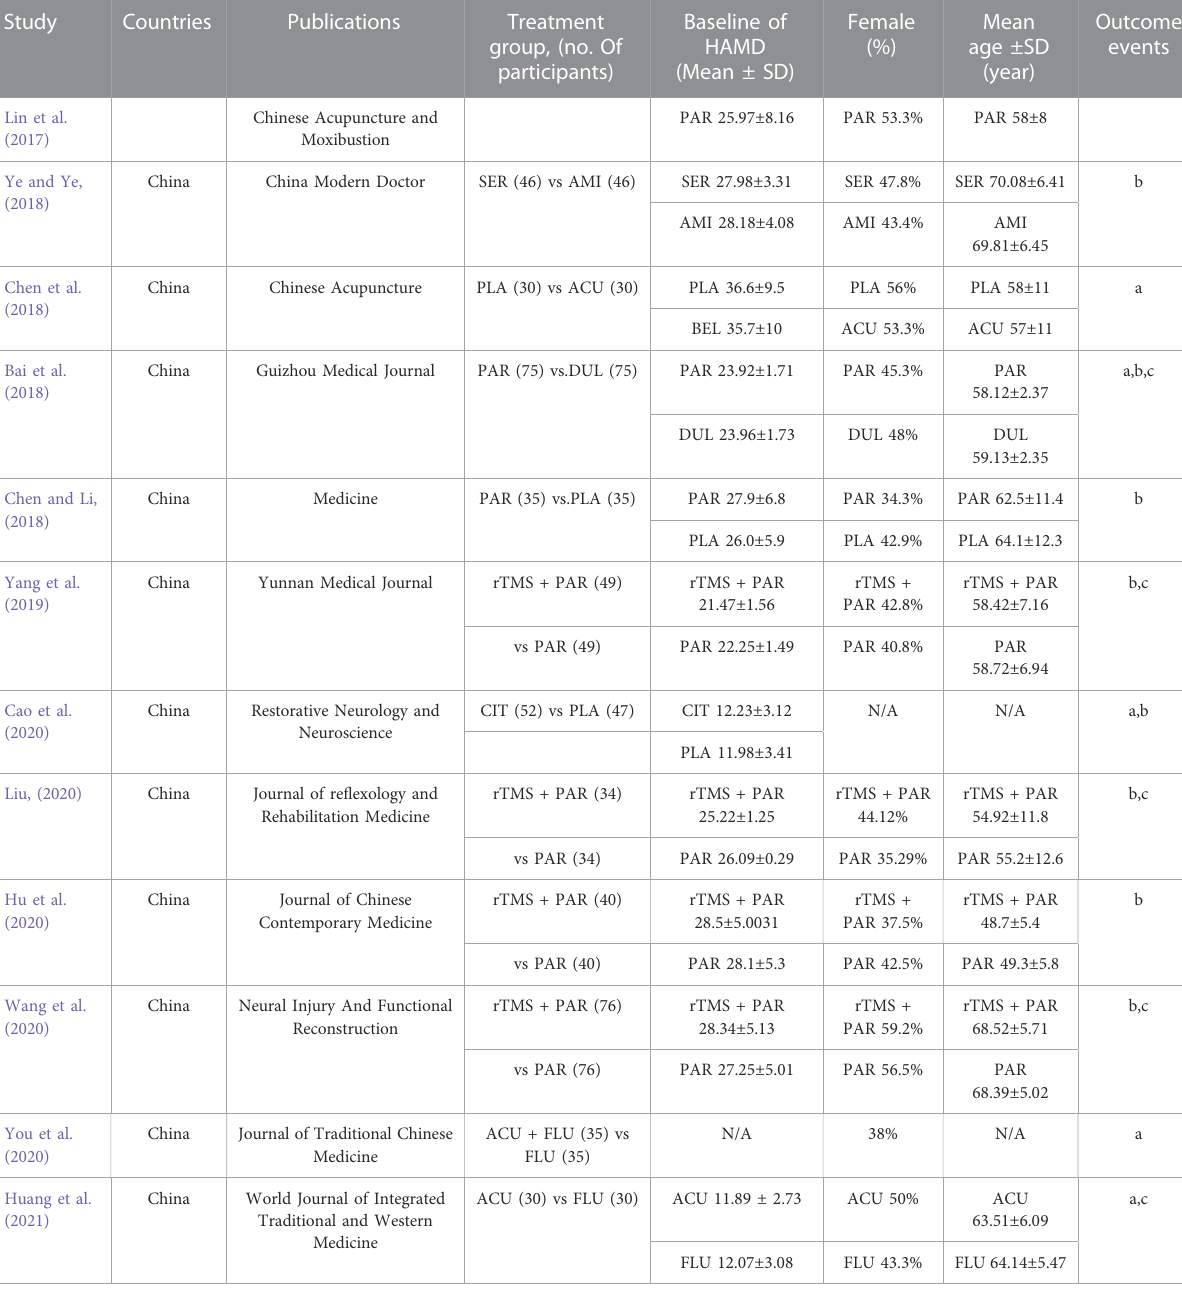
the contrary, without signi fi cant heterogeneity, a fi xed-effects comparing each node with the existence of direct, indirect,